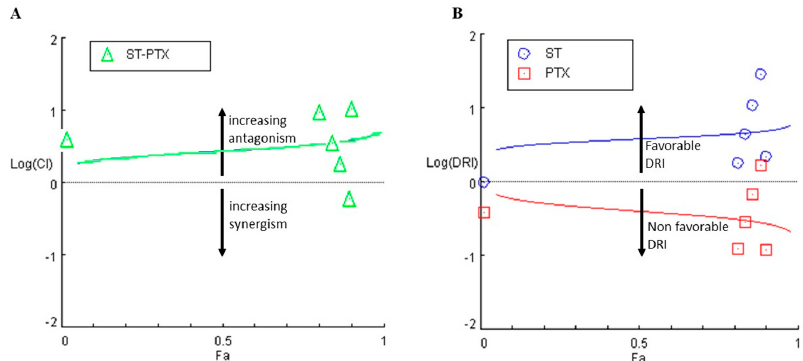
Table 6. Dose reduction index (DRI) values calculated at experimental points for SKOV3 cells.